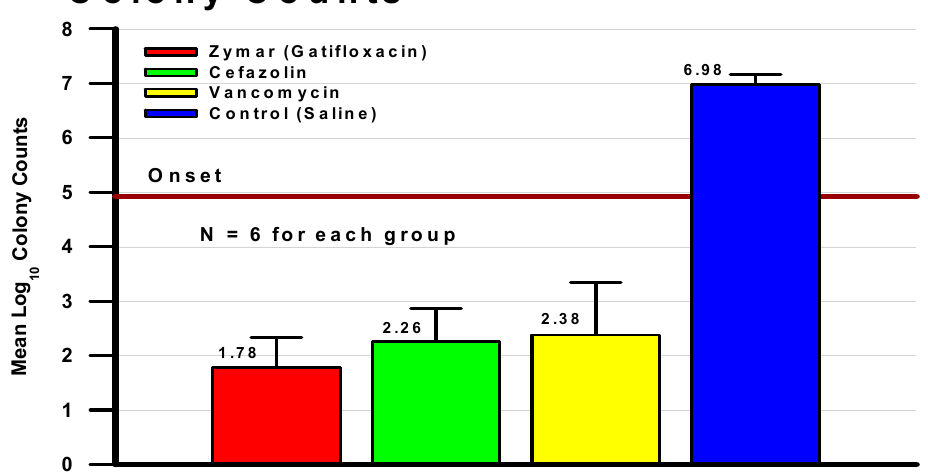
Figure 4. Topical treatment of MRSA keratitis with gatifloxacin, cefazolin, and vancomycin.